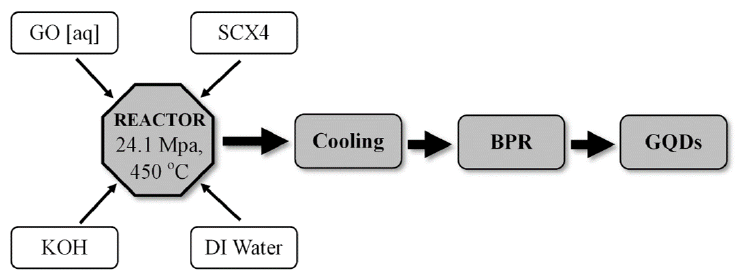
Figure 6: Flowchart of the continuous hydrothermal flow synthesis of graphene quantum dots from graphene oxide (GO) and calix[4] arene tetrasulfonic acid (SCX4) (Kellici et al ., 2017; Bandara et al .,